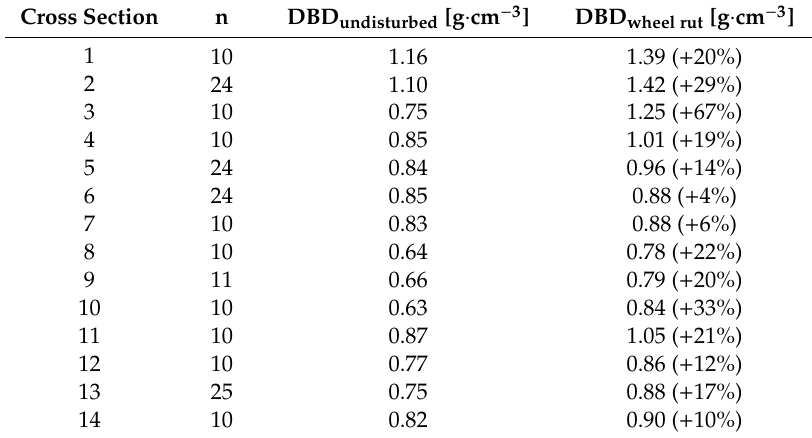
Table 3. Number of samples and di ff erences between undisturbed soil and wheel ruts regarding soil dry bulk density (DBD).